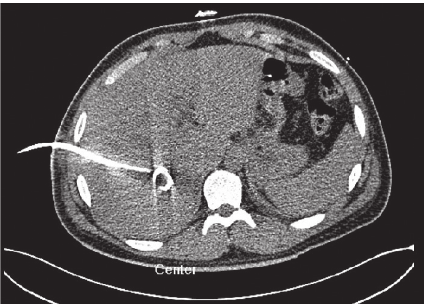
Figure 4: C.T. abdomen revealing the drain that was placed for the liver